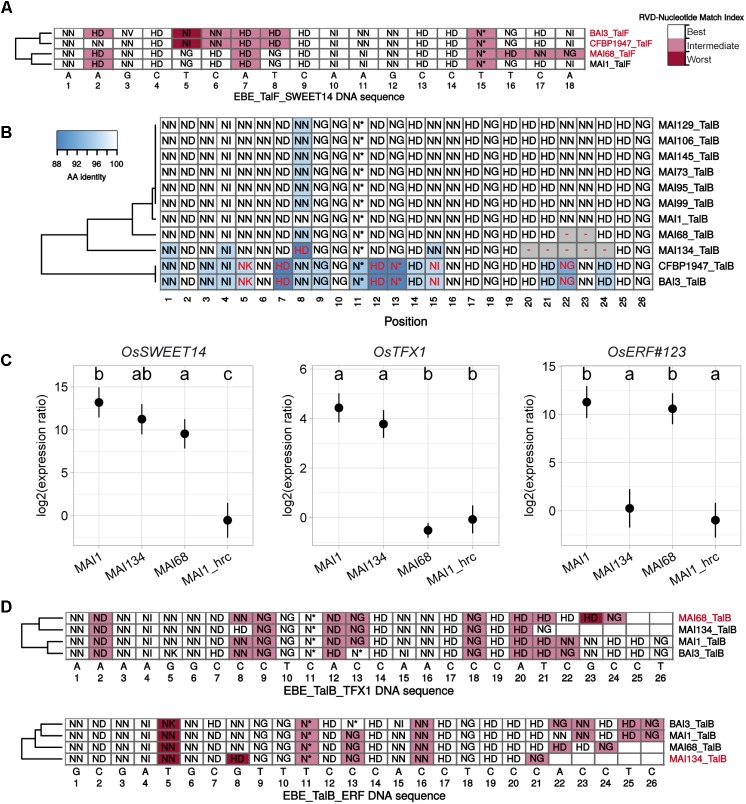
RVD sequence variability in the TalF and TalB groups has functional consequences on target gene induction activity. (A) Plain multiple alignment of selected TalF group RVD sequences (no gap allowed) along the DNA sequence (position| nucleotide as column labels) of TalFMAI1 predicted EBE on the promoter of OsSWEET14 in the Nipponbare genome. A background color was assigned to each RVD based on the quality of the match between this RVD and the MAI1 TalF EBE nucleotide at this position. A RVD-nucleotide pair was classified in the ‘Best’ category if this nucleotide is the one with the best score in the RVD-nucleotide association matrix used by Talvez. It was assigned to the ‘Worst’ category if it corresponded to the worst score in the association matrix and in the ‘Intermediate’ category otherwise. TALE variants with labels colored in pink do not presumably recognize the corresponding EBE. (B) Multiple DisTAL repeat unit sequences alignments of the central repeat regions of TALEs from the TalB group. See the legend of Figure 5 for details. (C) Target gene induction capacity of Malian strains MAI68 and MAI134 encoding TalB variants with repeat deletions. Q-RT-PCR was conducted on rice cultivar Kitaake total RNA extracted from leaf samples 48 h after infiltration of the designated bacterial strains. MAI1_hrc corresponds to the Type III Secretion System mutant derivative of MAI1. Average (points) and standard deviation (lines) of log2-transformed target gene (plot label) induction ratios relative to water treatment were computed from three biological replicate samples. Means having identical letters on top of the plotting area are not significantly different based on a Tukey’s HSD test (a = 0.05). This experiment was performed twice with similar results. (D) Plain multiple alignment of selected TalB group RVD sequences (no gap allowed) along the DNA sequence (position| nucleotide as column labels) of MAI1 TalF predicted EBE on the promoter of OsTFX1 or OsERF#123 in the Nipponbare genome. See the legend of (A) for details.